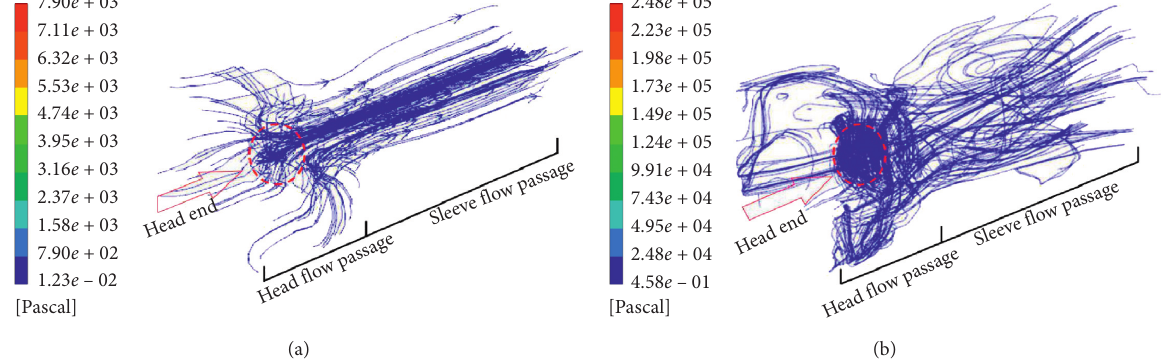
Figure 12: Head end trace diagram at 80 ° flap angle. (a) 50,000m 3 . (b) 200,000 m 3